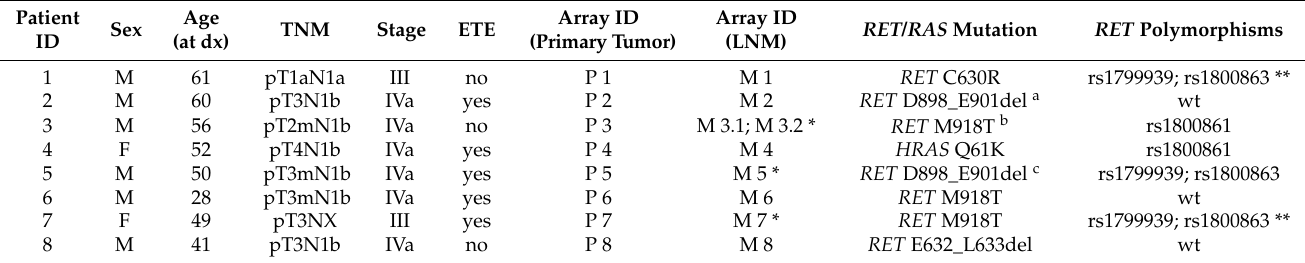
Table 2. Characteristics of the eight proprietary sporadic MTC patients.